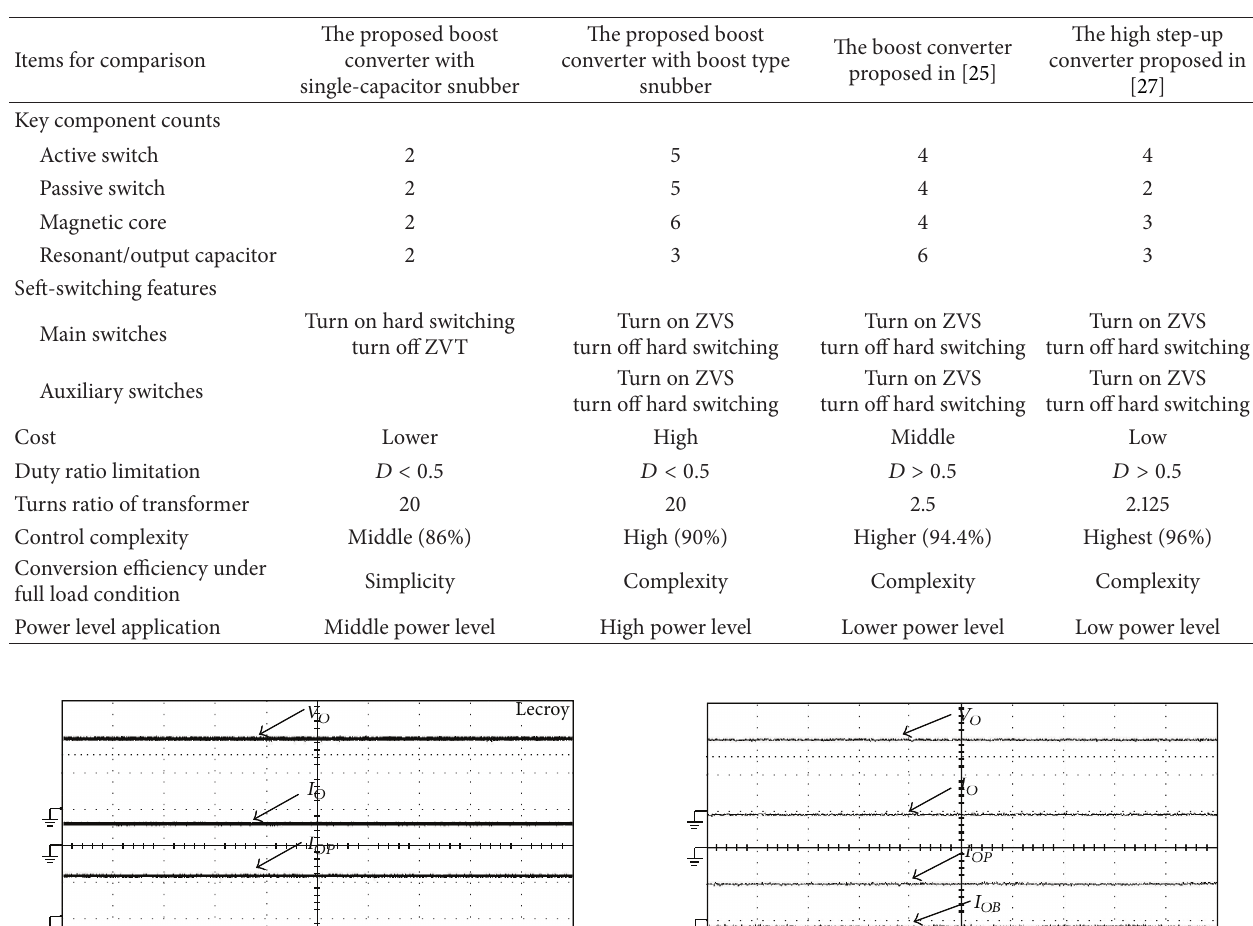
Table 2: Preliminary comparisons among the different high step-up converters for the PV power system.